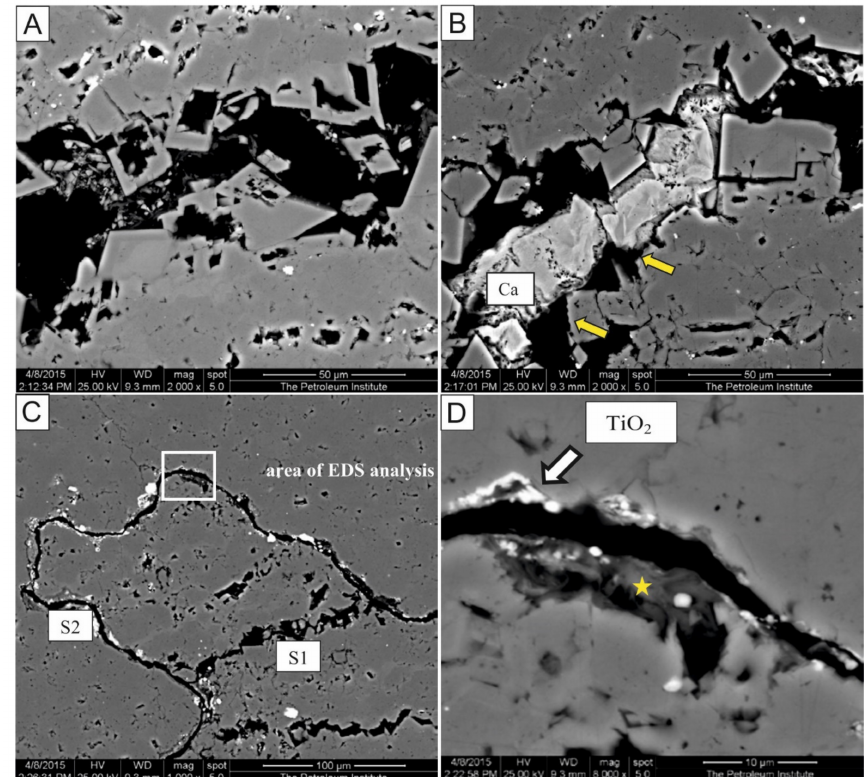
Figure 6. BSE images showing: ( A ) The presence of dolomite along a dissolution seam within a pebble. The core of rhombic dolomite crystals is dissolved while the rim is preserved. ( B ) Calcite cement (Ca) along the dissolution seam within the pebble, which precipitates after dissolution of dolomite (shown by an irregular boundary of dolomite crystal, yellow arrows). ( C , D ) stylolite/seams (S1 and S2) cutting across each other and the clay mineral and TiO 2 occur along the stylolite/solution seam within a